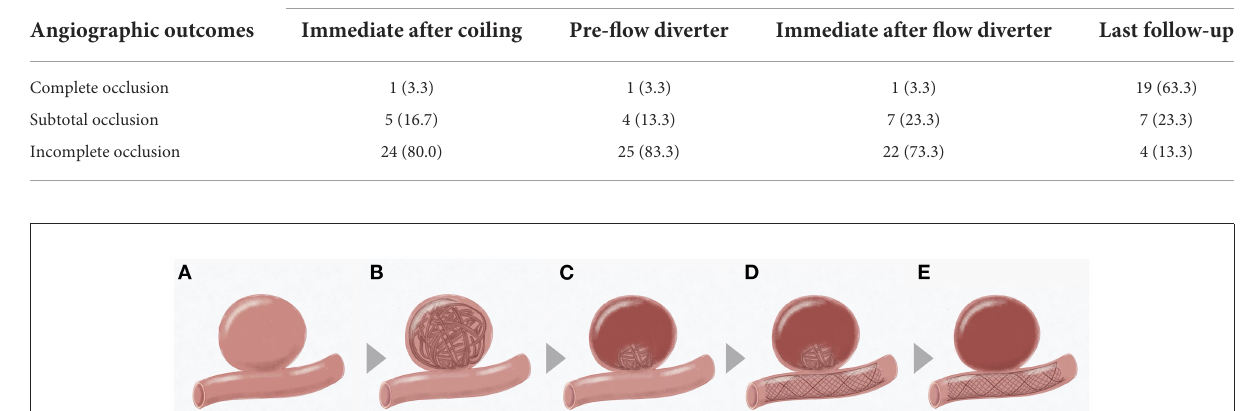
TABLE 3 Radiologic outcomes.